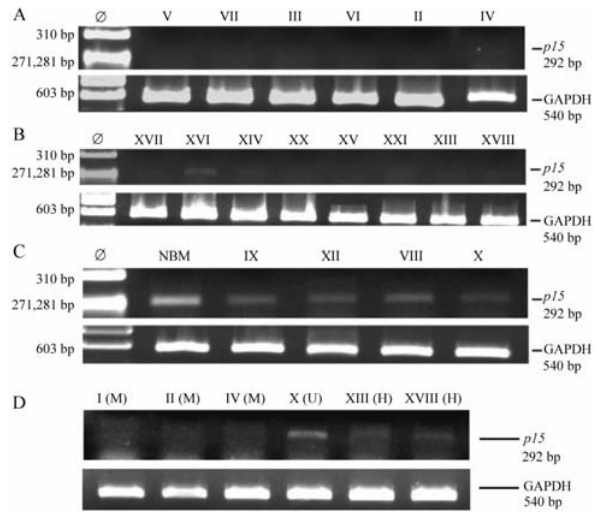
Figure 2 - CDKN2B mRNA expression evaluated by RT-PCR. NBM = normal bone marrow. The samples are represented in roman num- bers. (A) methylated samples (B) hemimethylated samples. (C) unmethylated samples. (D) Comparative RT-PCR. GAPDH was used to control the integrity of the RNA samples.